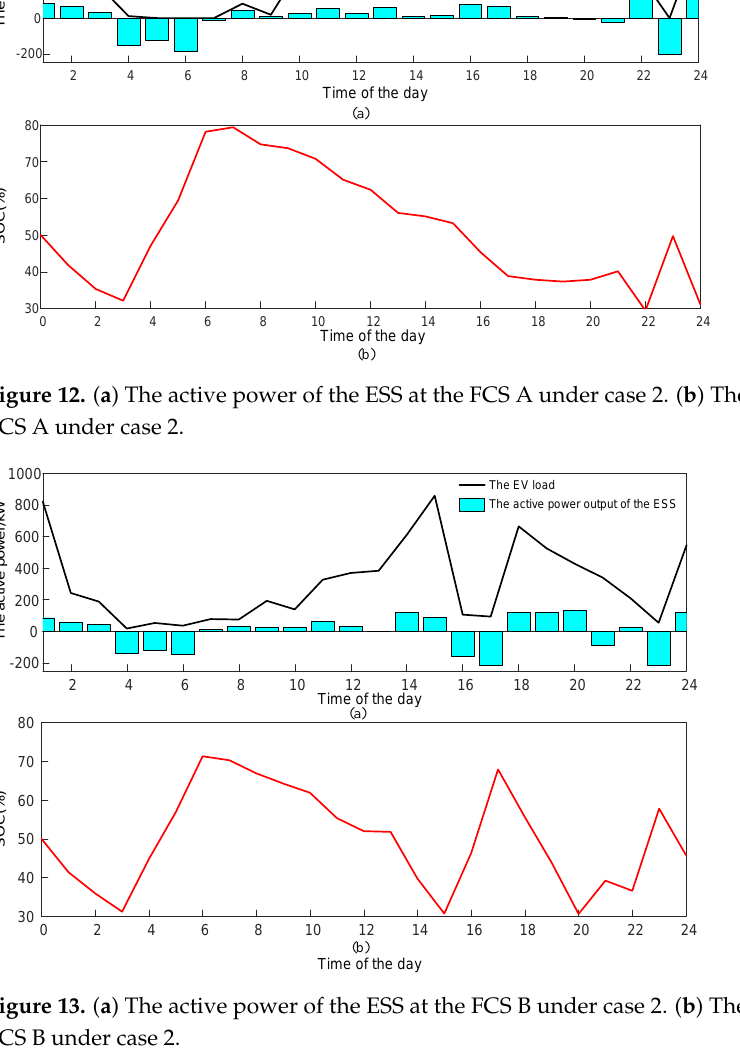
Figure 13. ( a ) The active power of the ESS at the FCS B under case 2. ( b ) The SOC of the ESS at the FCS B under case 2.